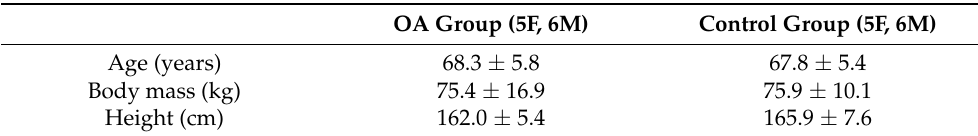
Table 1. Demographic and anthropometric characteristics of participants. Values are expressed as mean ±